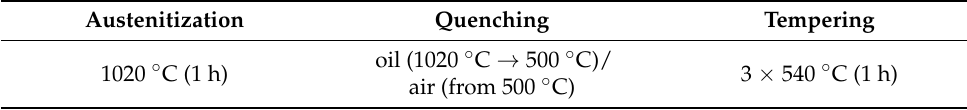
Table 1. Heat-treating (QT) parameters for PBF-EB-processed